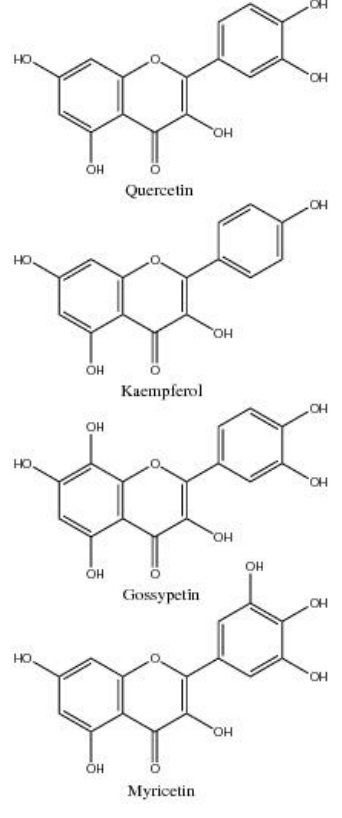
Figure 3. Flavonol aglycones found in cotton.